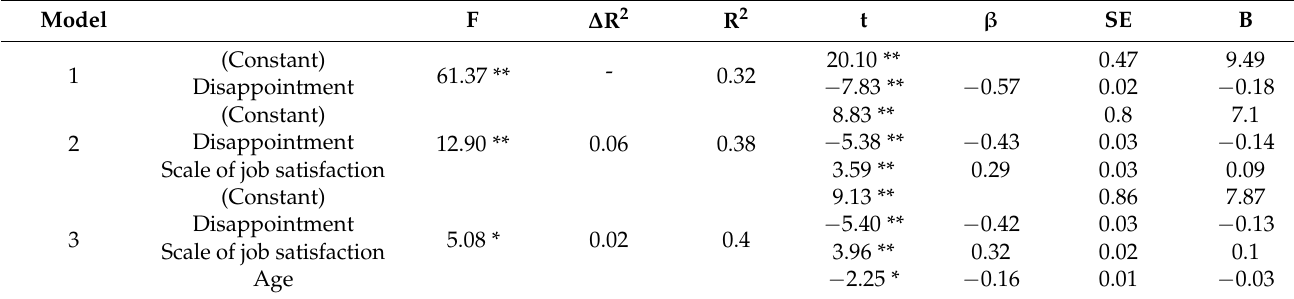
Table 5. Predictors of overall job satisfaction.